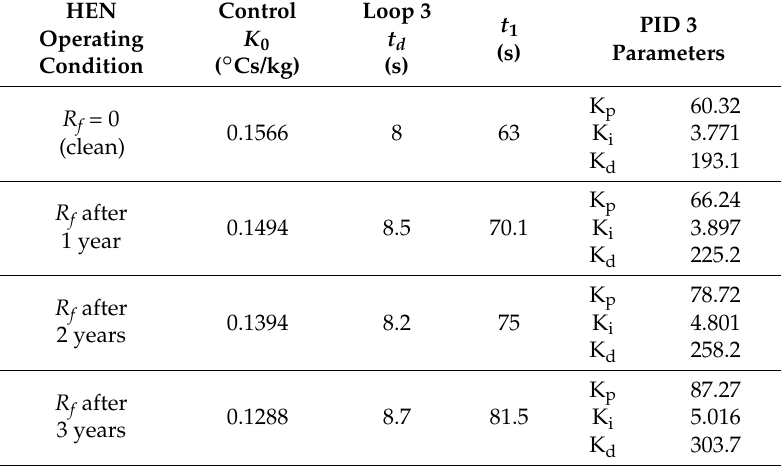
Table 4. Values of PID controller parameters obtained using the Ziegler-Nichols method [18] in case no. 2.